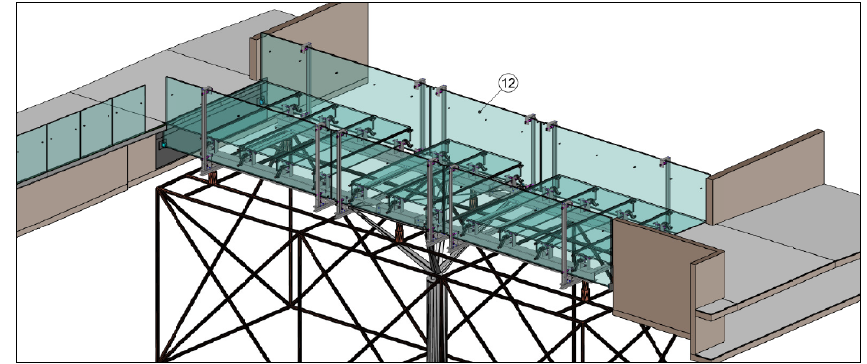
Figure 6: Installation Sequence 12) Installation and adjustment of all glass balustrade elements